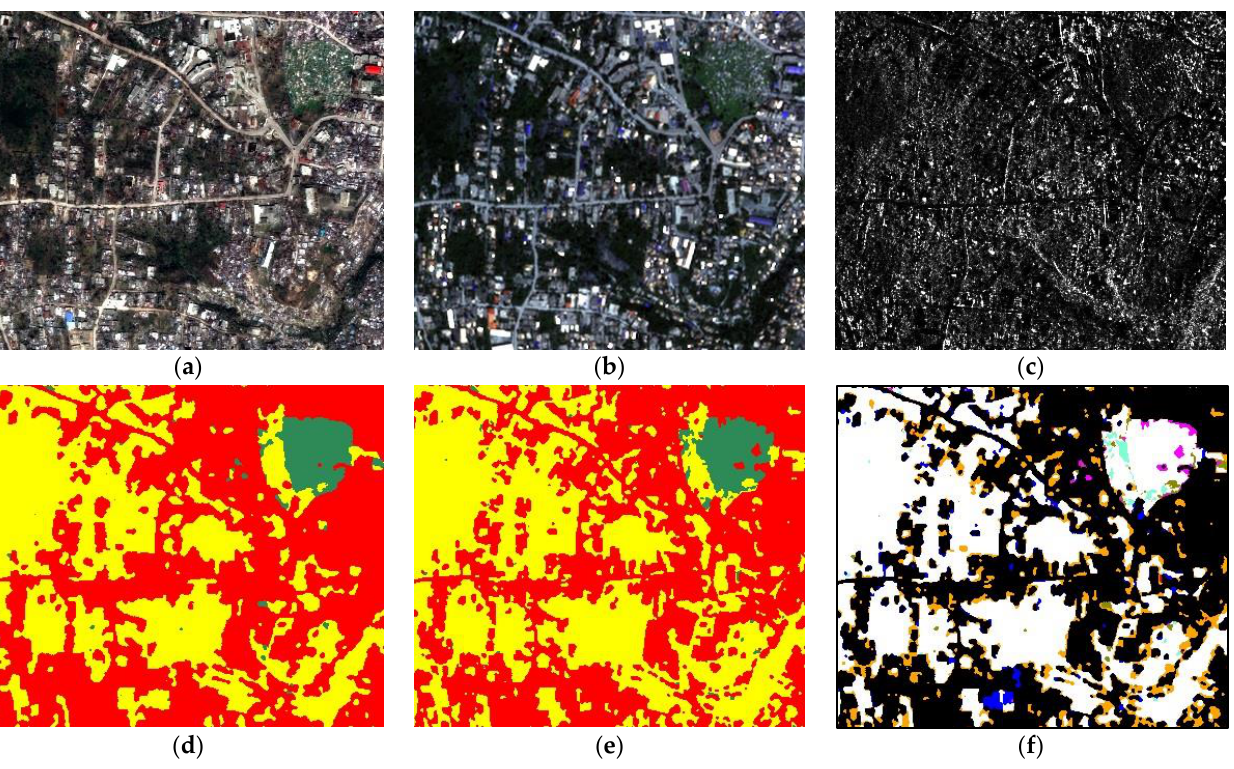
Figure 10. Details of the 2016 and 2017 datasets: ( a ) RGB composition of the optical image acquired in 2016; ( b ) RGB composition of the optical image acquired in 2017 (image © CNES 2016–2017, distribution Airbus DS); ( c ) grey-level representation of the SAR image acquired in 2017 (COSMO-SkyMed Product © ASI—Italian Space Agency—2017. All rights reserved.); ( d ) classification map corresponding to 2016; ( e ) classification map corresponding to 2017; ( f ) change map specifying the changes that happened between 2016 and 2017. The legend of the change map is displayed in Figure 11, while the legend of the classification maps is provided in Table 3.